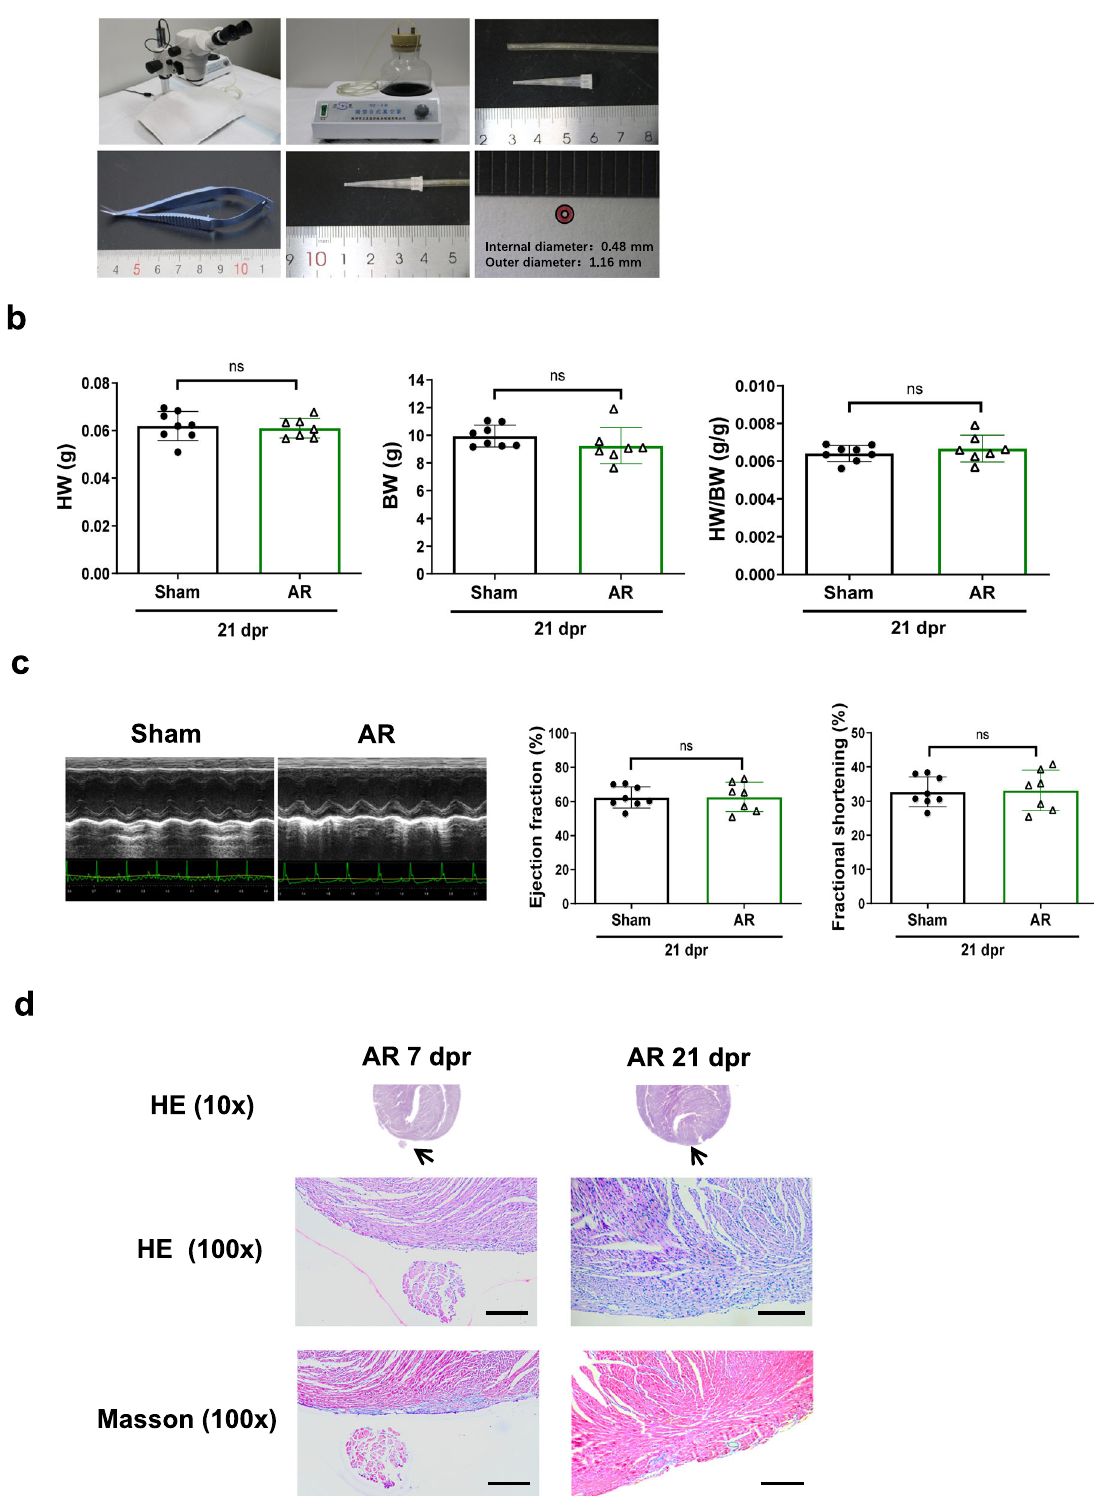
Fig. 2 Cardiac structural and functional recovery after modi fi ed apical resection surgery in 1-day-old neonatal mice. a A stereoscope, a desktop vacuum pump, and a modi fi ed 10 μ L pipette tip with its tip cut to 0.48 mm in internal diameter using a sharp blade, were prepared for modi fi ed apical resection (AR) method. b Heart weight (HW), body weight (BW), and heart weight/body weight ratio (HW/BW) at 21 days post resection (dpr) ( n = 7-8). c Echocardiography for left ventricle ejection fraction and fractional shortening at 21 dpr ( n = 7-8). d Representative images for hematoxylin-eosin (HE) and Masson ’ s trichrome staining for AR hearts at 7 dpr and 21 dpr. Scale bar = 200 μ m. ns not signi fi cant. All data are expressed as means ±